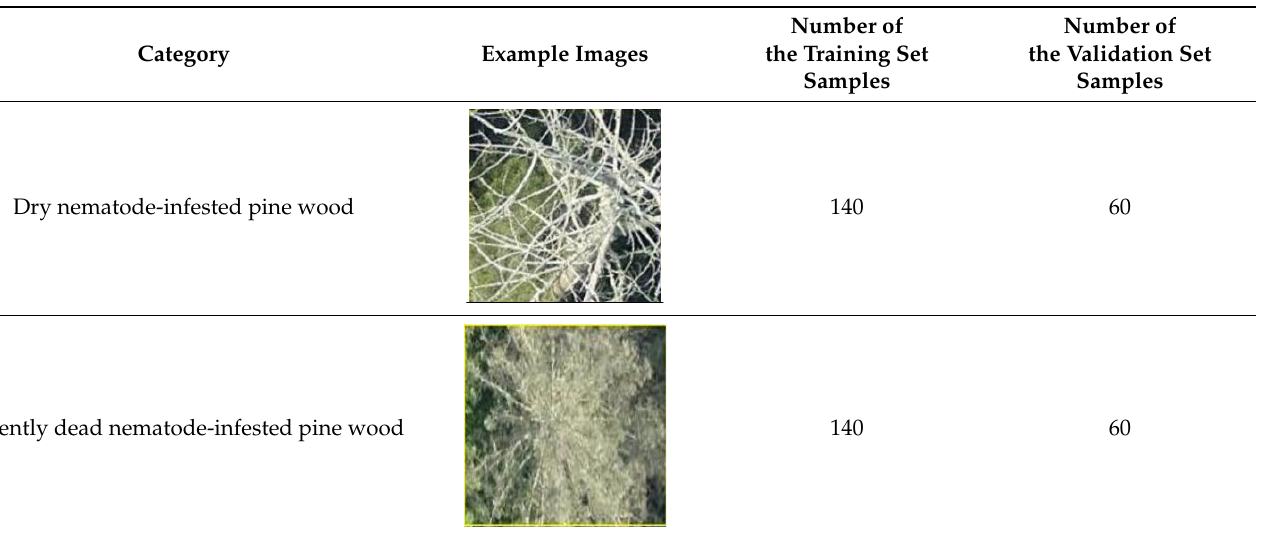
Table 1. Recognition classification model dataset.